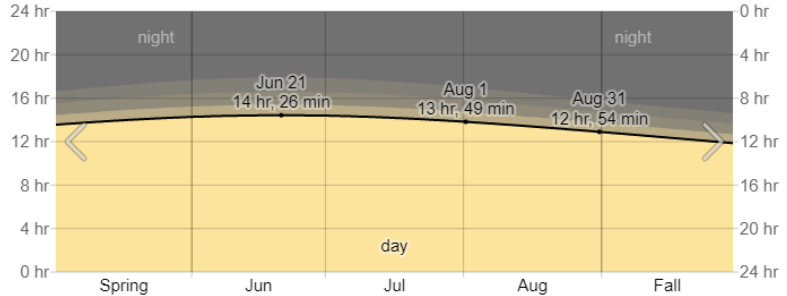
Figure 6. Hours of daylight and twilight in the in Los Angeles, California [36].